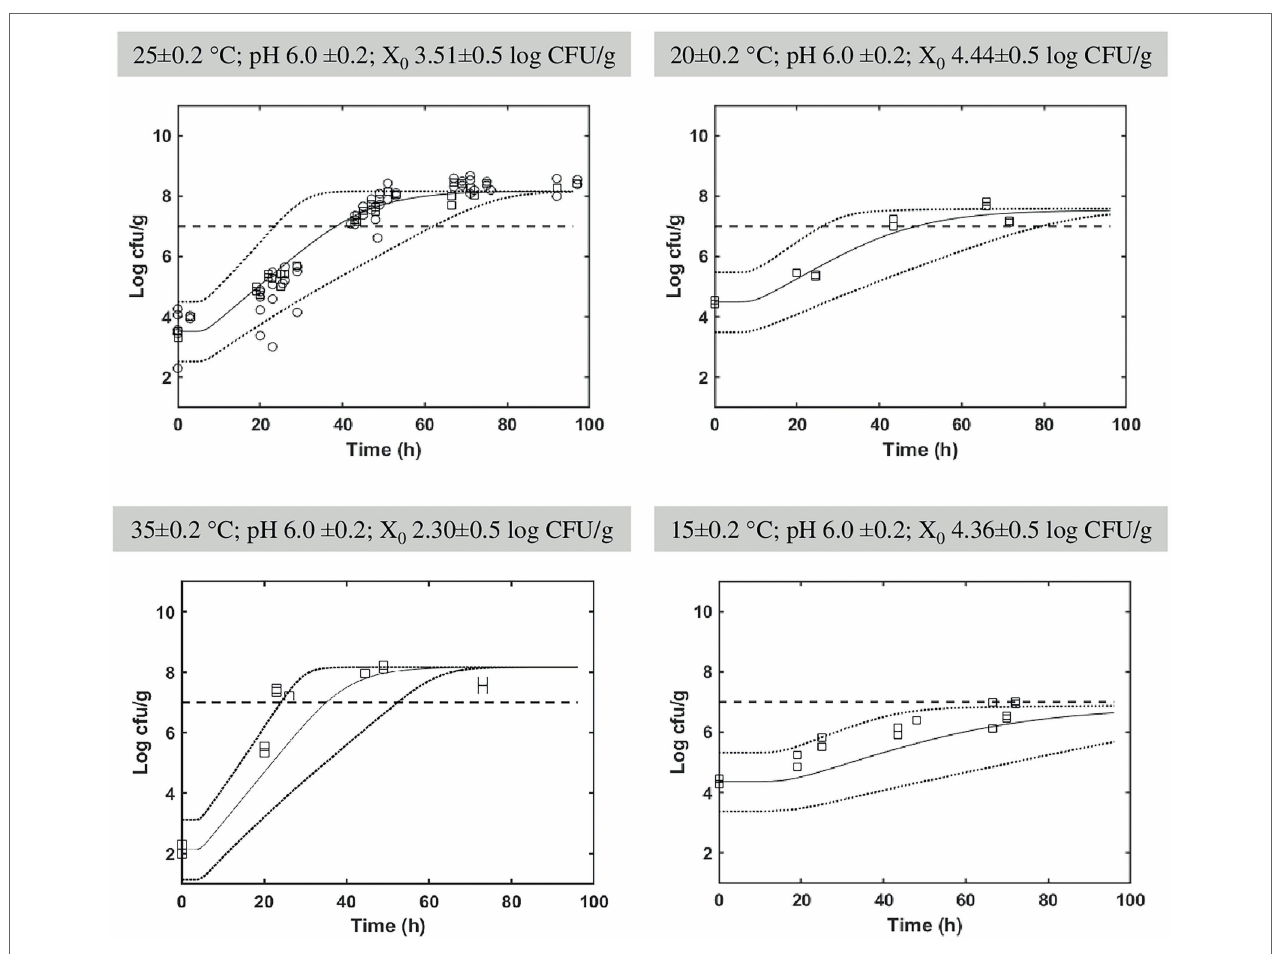
FIGURE 2 | Comparison between in food growth of Lacticaseibacillus paracasei from all experimental data relevant to Table 1 (squares), additional data generated at 25 ° C not included in Sarvan et al. (Sarvan et al., 2013; circles) and the prediction in silico (line) with confidence interval (dashed lines). The stochastic simulations were performed using the normal distributions by the calculated mean values of the growth parameters and relevant standard deviations obtained for the four Lacticaseibacillus paracasei strains ( Table 2 ).